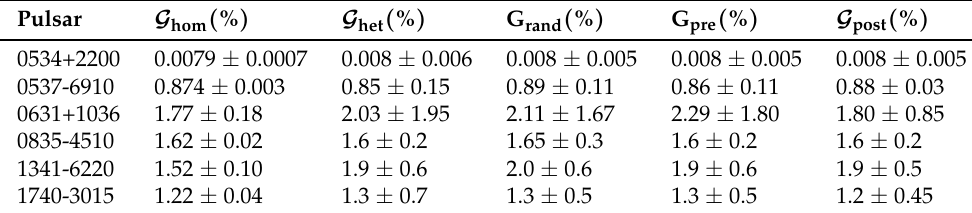
Table 1. Dimensionless activities and their standard deviations, calculated for the six pulsars with the largest number of glitches, with a least-squares linear fit on the cumulative midpoints assuming homoscedasticity ( G hom ), with a least-squares linear fit assuming heteroscedasticity ( G het ), with a bootstrap on the size and waiting time samples separately ( G rand ), and on the pairs’ size, preceding waiting time ( G pre ), and size, following waiting time ( G post ). Pulsar G hom ( % ) G het ( % ) G rand ( % ) G pre ( % ) G post ( % ) 0534+2200 0.0079 ± 0.0007 0.008 ± 0.006 0.008 ± 0.005 0.008 ± 0.005 0.008 ± 0.005 0537-6910 0.874 ± 0.003 0.85 ± 0.15 0.89 ± 0.11 0.86 ± 0.11 0.88 ± 0.03 0631+1036 1.77 ± 0.18 2.03 ± 1.95 2.11 ± 1.67 2.29 ± 1.80 1.80 ±